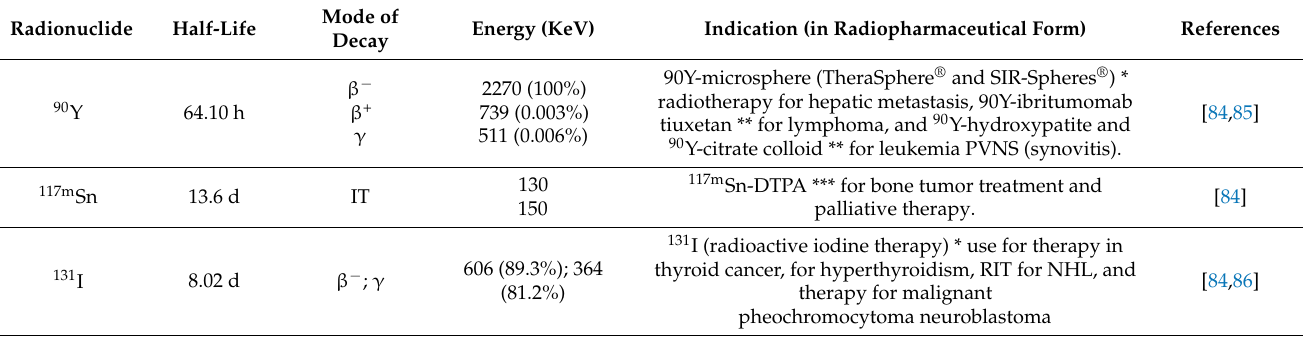
Table 3. Radionuclides for therapy